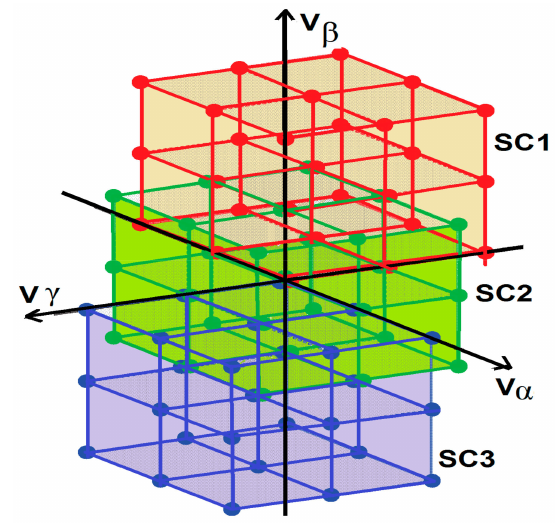
Figure 5. 3D-SVM cubic structure with α - β - γ coordinate